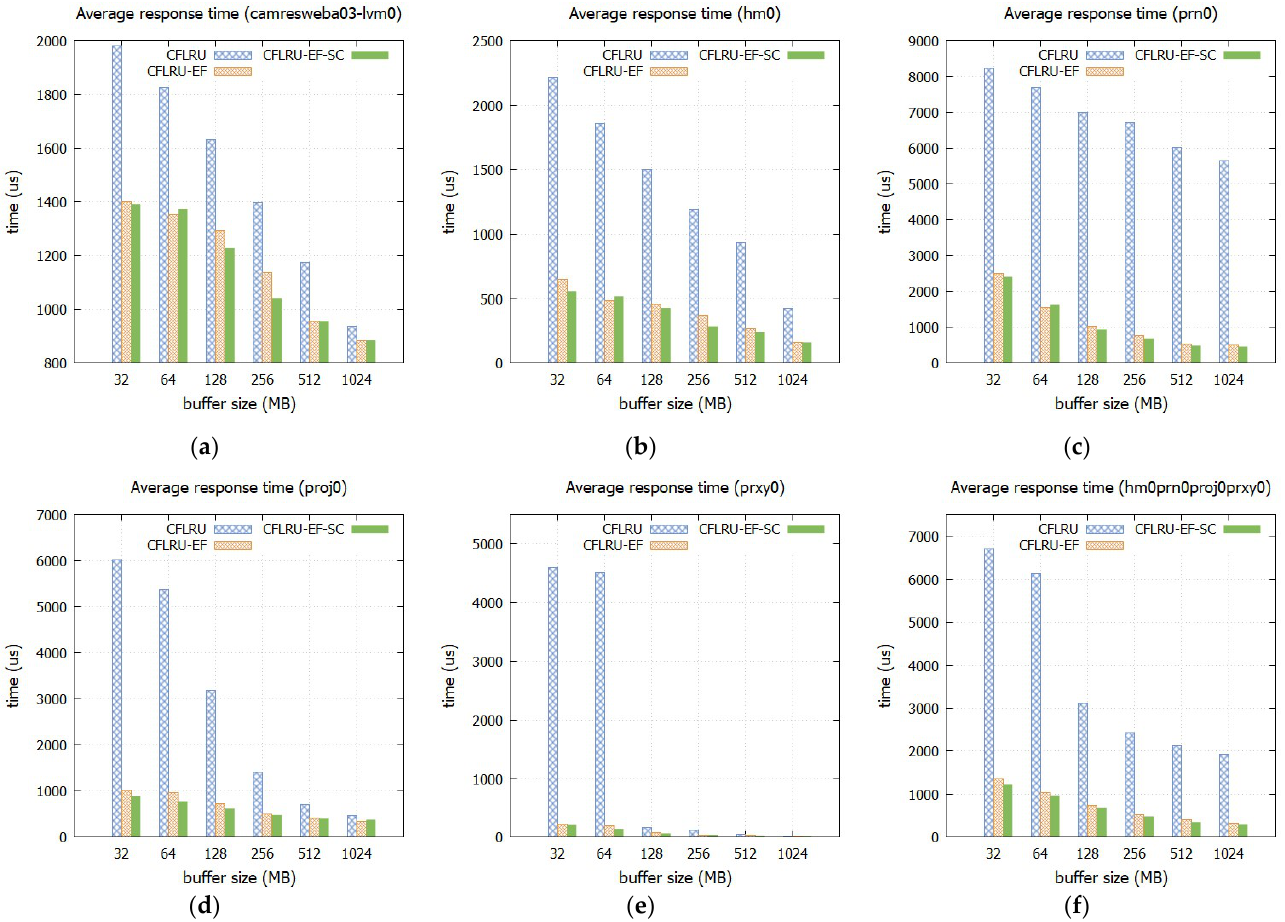
Figure 4. Average response time. ( a ) camresweba03-lvm0; ( b ) hm0; ( c ) prn0; ( d ) proj0; ( e ) prxy0; ( f ) hm0prn0proj0prxy0.